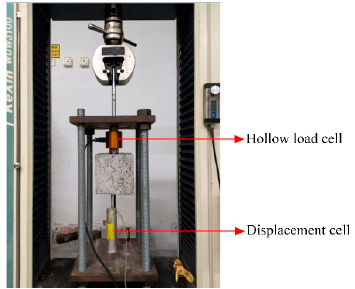
Figure 9. Test set-up for pull-out test.